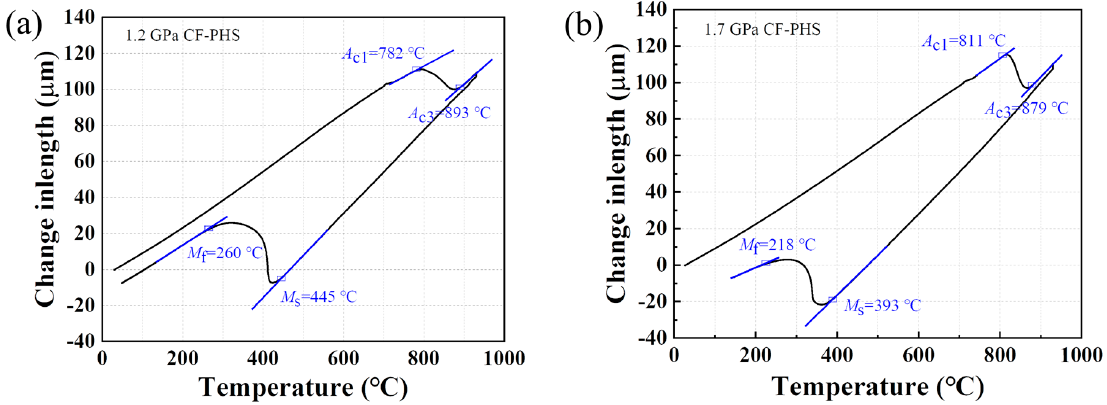
Figure 1. Dilatometric curves of CF-PHSs with ( a ) 1.2 GPa and ( b ) 1.7 GPa.